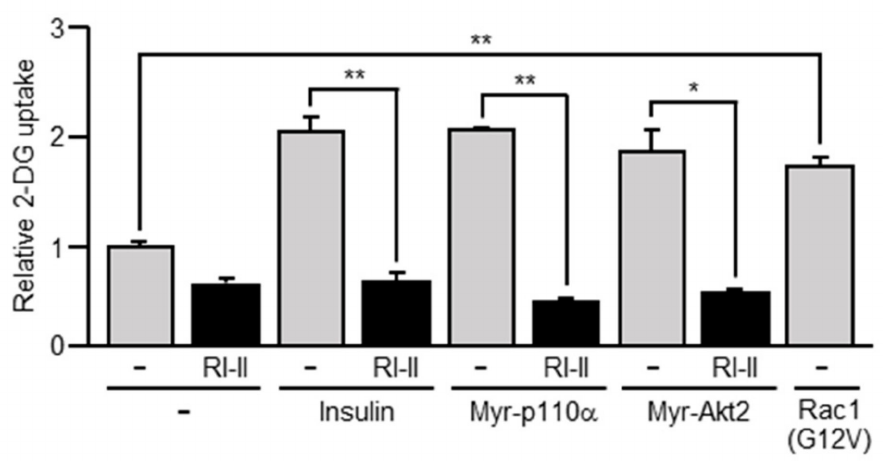
Figure 4. The uptake of 2-deoxy-D-glucose (2-DG) induced by insulin or a constitutively activated mutant of PI3K, Akt2, or Rac1. 3T3-L1 adipocytes were infected with the control (-), Myr-p110 α -expressing, Myr-Akt2-expressing, or Rac1(G12V)-expressing virus. The uptake of 2-DG in these adipocytes was measured. The e ff ect of RI-II on the uptake of 2-DG was also tested. Data are shown as means ± S.E. ( n = 3). * p < 0.05; ** p <